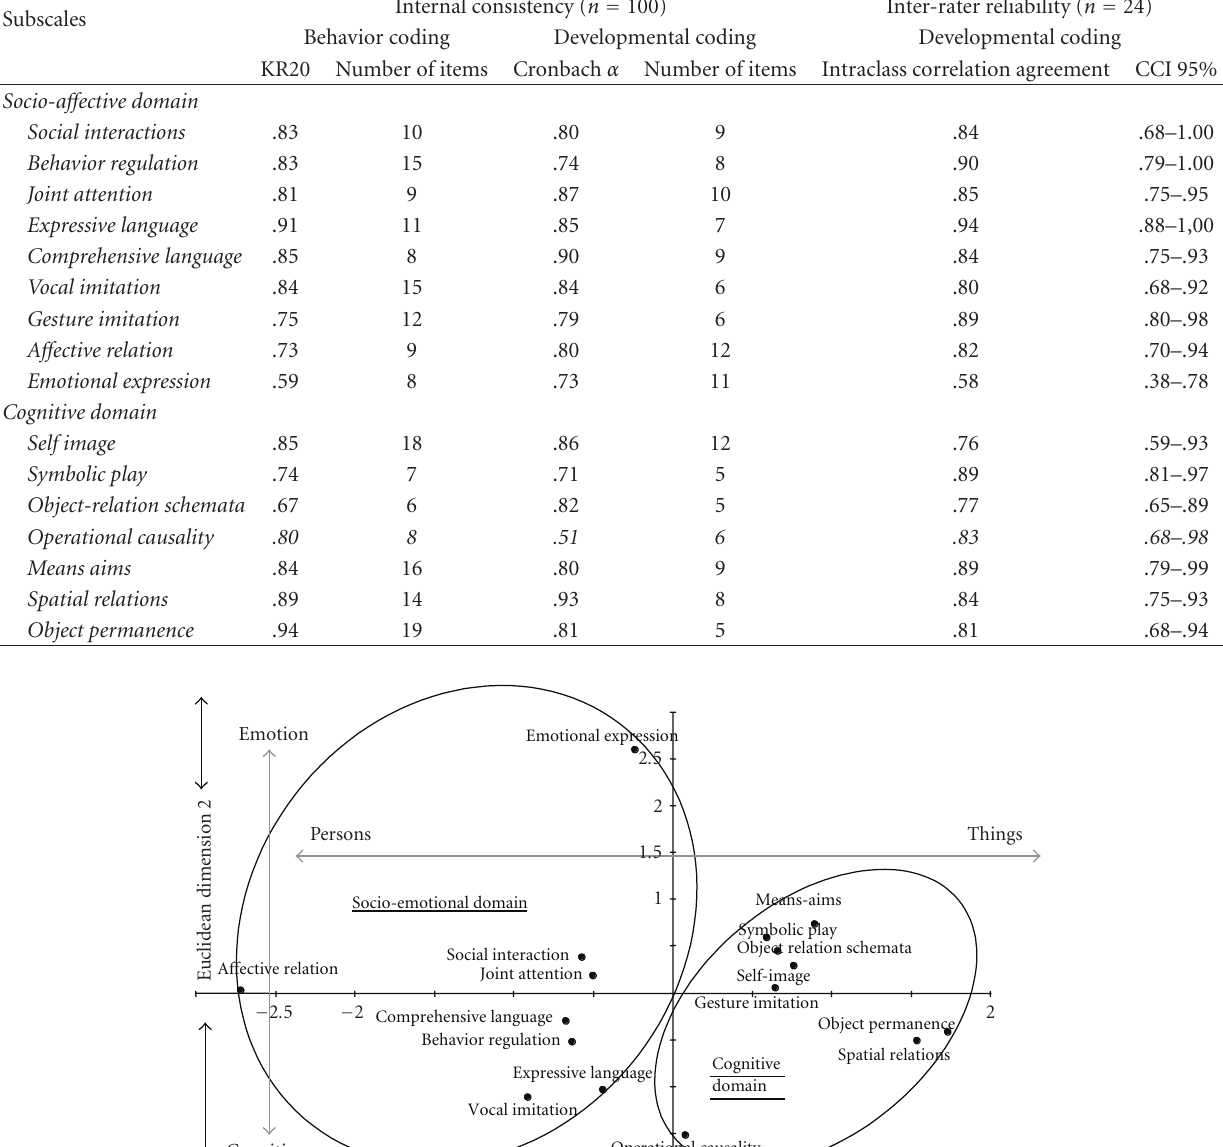
Table 4: Subscale Internal Consistency for Behavior Observation Grids, internal consistency and intraclass correlation agreement for Developmental Level Scales.